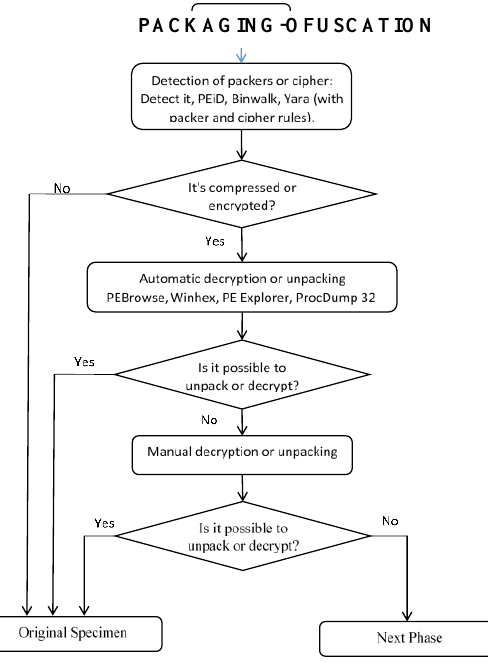
Figure 6. Unpacking and decryption process.